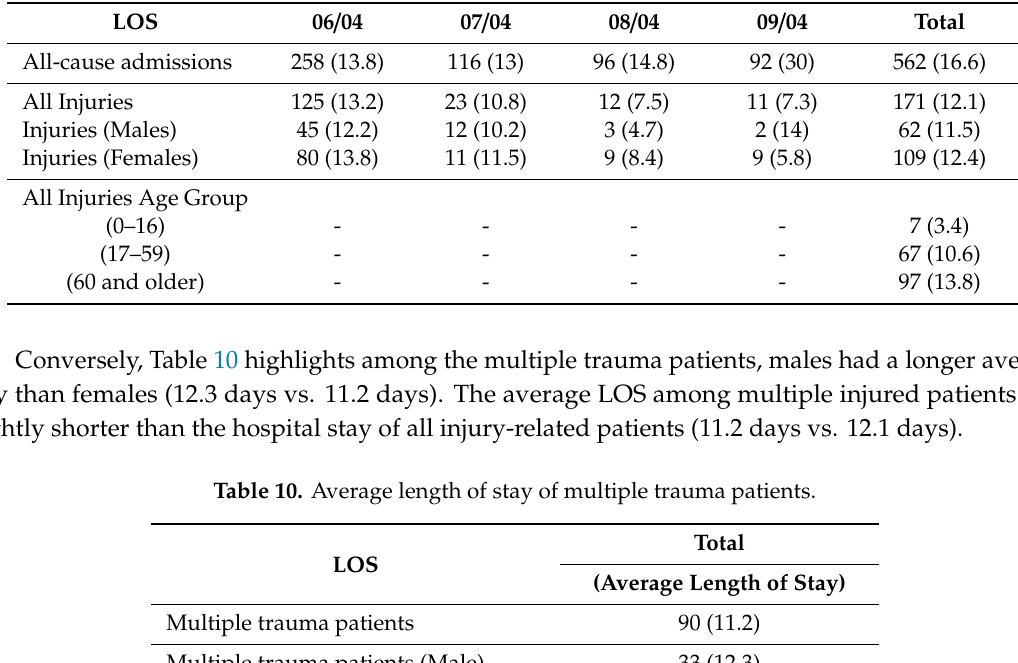
Table 9. Average length of stay (in parentheses) by all-cause hospital admissions, injuries, days, age group and sex.